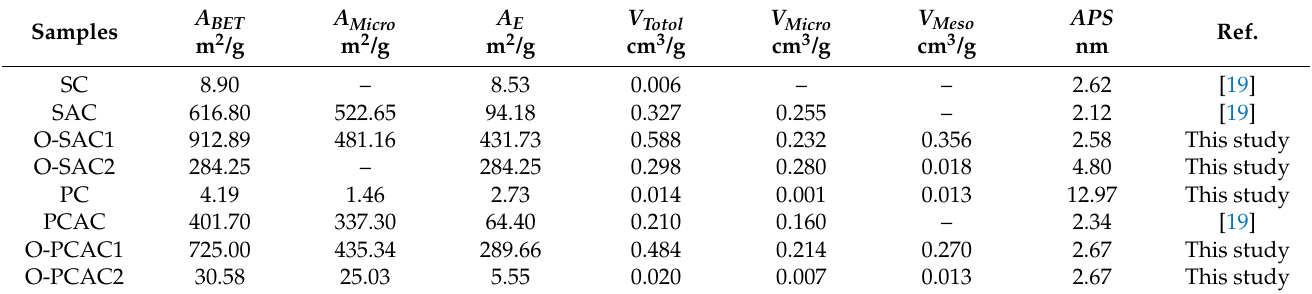
Table 1. Textural characteristics of all materials used in this